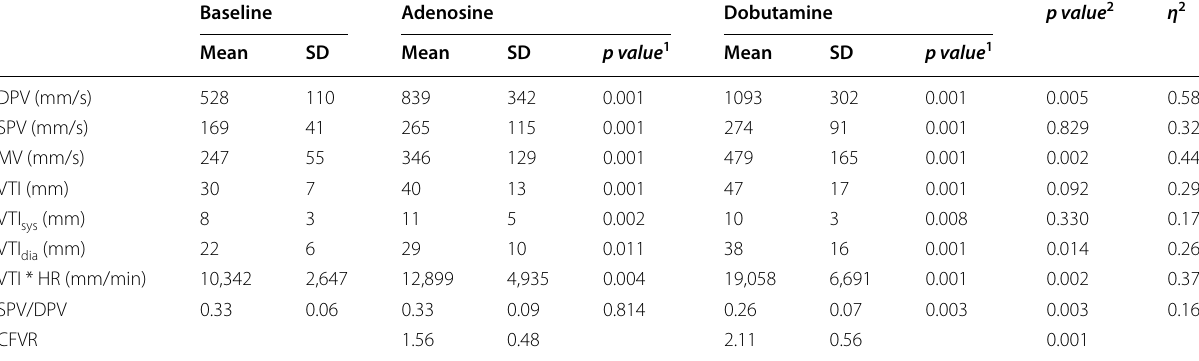
Table 2 Pulsed-wave Doppler-derived blood flow values from the proximal left coronary artery of eight rats